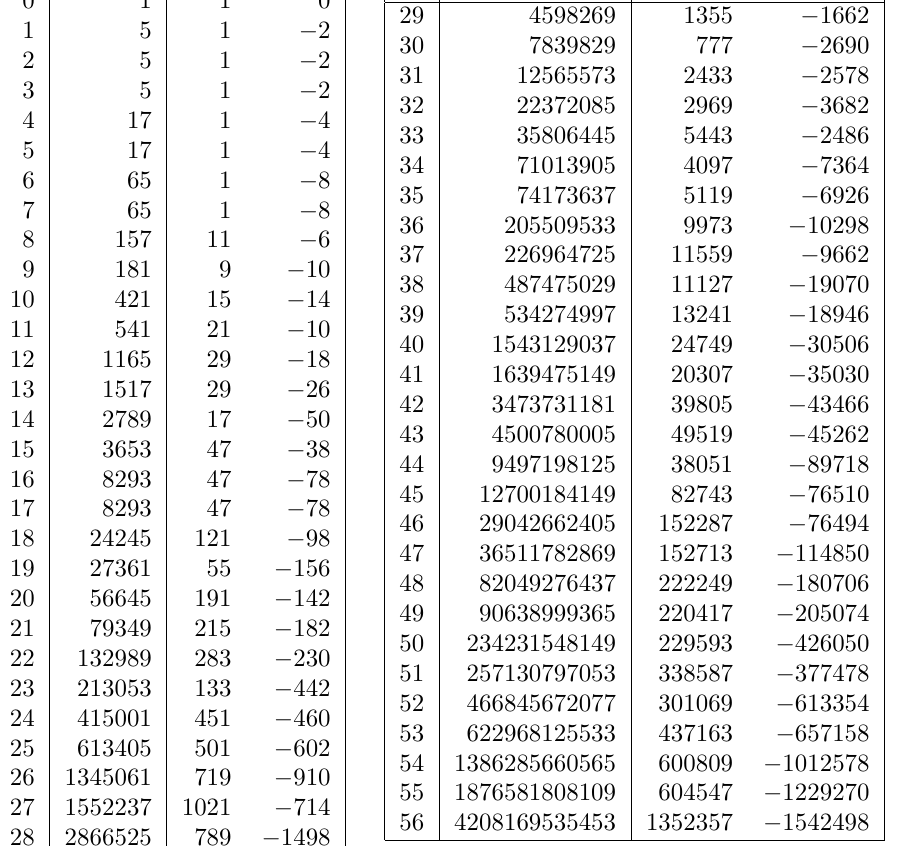
Figure G.5: For each s ∈ { 0 , 1 , . . . , 56 } : Minimum R 2 R 1 is an even integer, and ( R 0 , R 1 ) requires ≥ s iterations of divstep. Also, an example of ( R 0 , R 1 ) reaching this